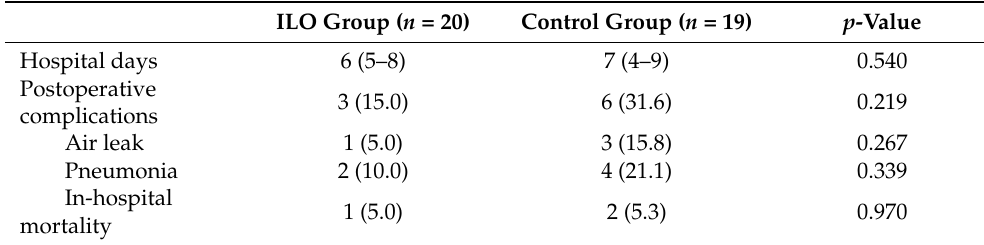
Table 4. Short-term